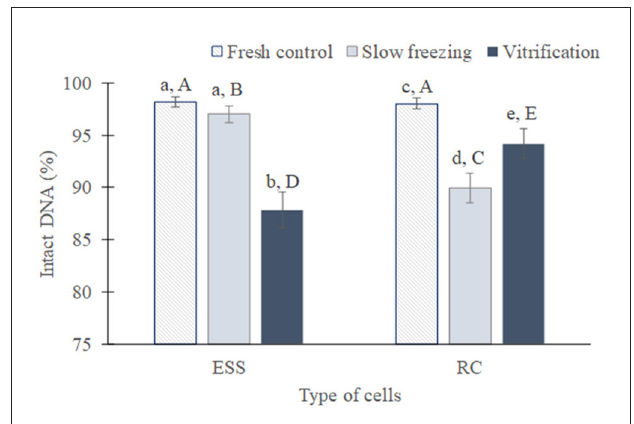
FIGURE5 Global DNA integrity of testicular cells (mean from all species ± SEM) from fresh, slow frozen-thawed and vitrified-warmed samples. Different lowercase letters represent differences ( P < 0.05) between treatments for each cell type. Different capital letters represent differences ( P < 0.05) between cell types in each treatment. ESS, elongated spermatids and spermatozoa; RC, rounded cells (spermatogonia, spermatocytes, early